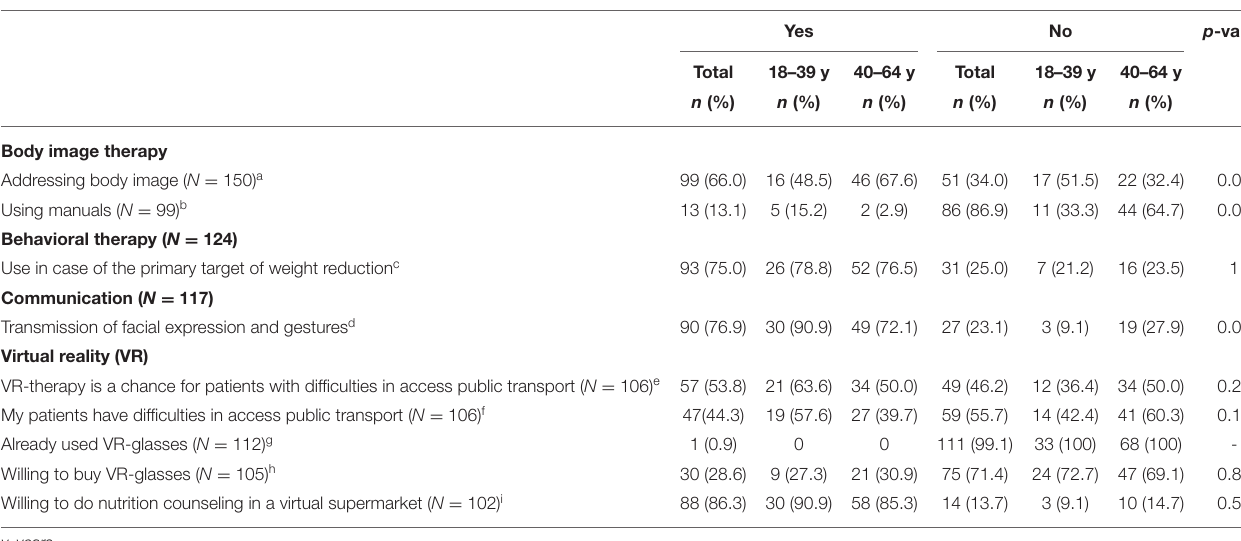
TABLE 4 | Body image and behavioral therapy, communication, and virtual